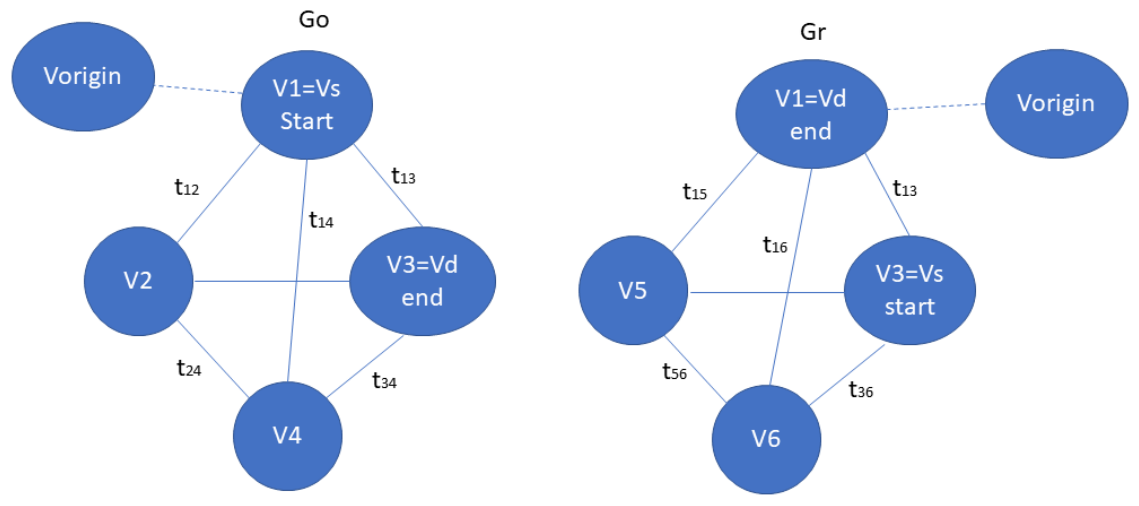
Figure 1. G o and G r graph